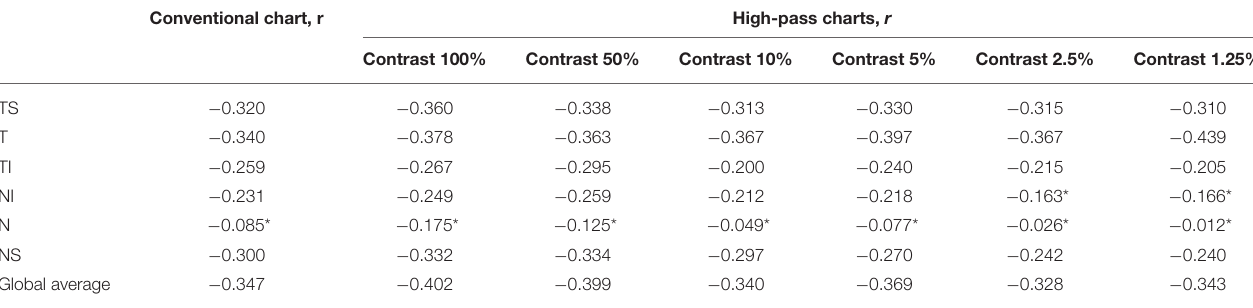
greater level of disagreement between conventional VA and high- pass VA ( Figure 5 ). Even at the 100% contrast level, there is a significant difference between the two VAs. Part of this might be patients with normal vision and the healthy controls ( − 0.09